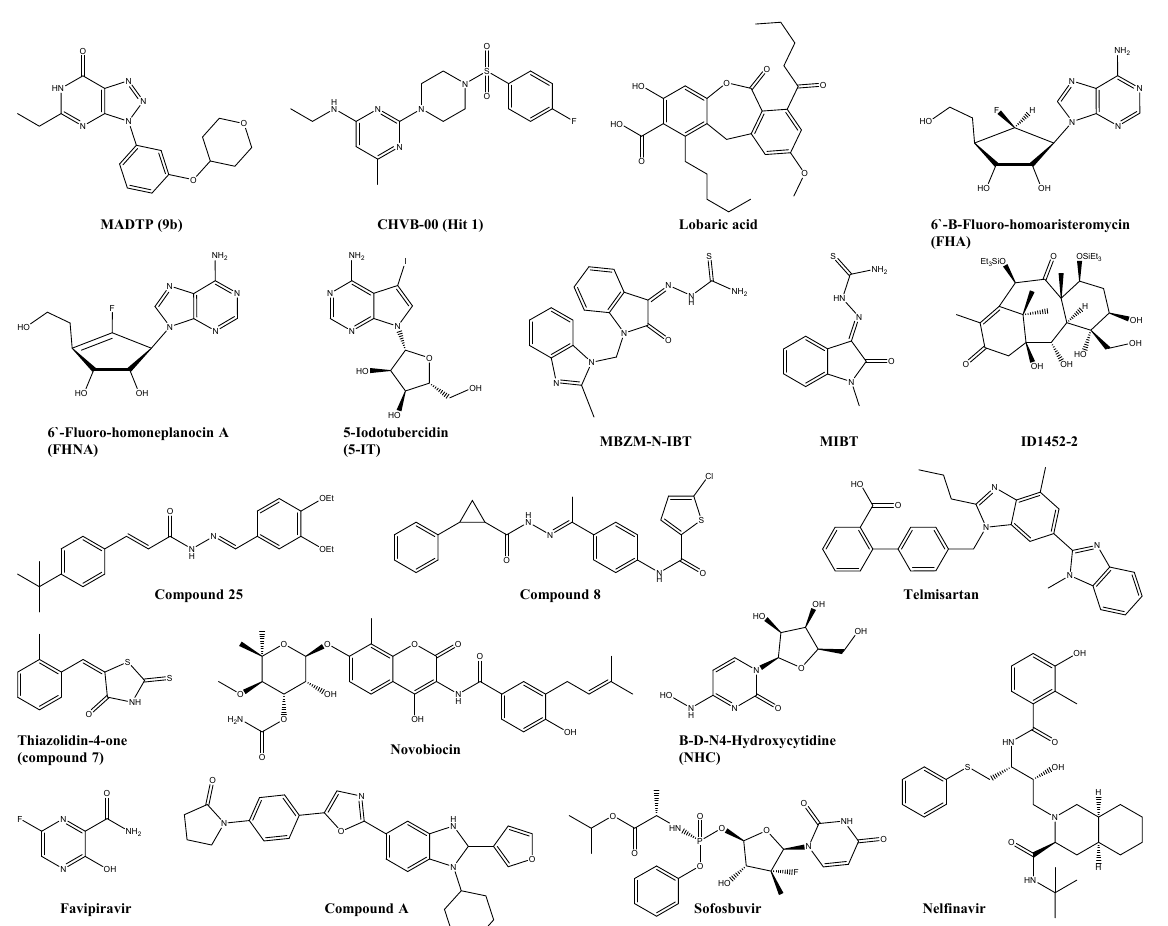
Figure 2. Chemical structure of virus-targeting compounds. Inhibitors of nsP1: MADTP, CHVB, lobaric acid, 6`- β -fluoro- homoaristeromycin, 6`-fluoro-homoneplanocin A, and 5-iodotubercidin. Inhibitor of nsP2: compound 25, compound 8, MBZM-N-IBT, MIBT, thiazolidin-4-one, ID1452-2, telmisartan, novobiocin, and nelfinavir. Inhibitor of nsP4: favipiravir, β -D-N4-Hydroxycytidine, sofosbuvir, and compound-A.